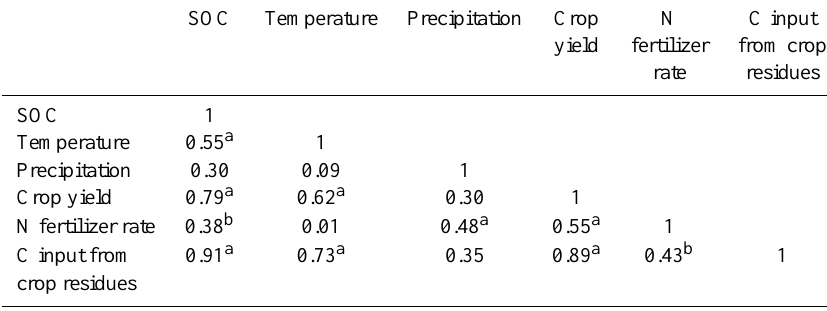
Table 1. Correlation analysis between SOC content of cropland and driving factors in Huantai County. SOC Temperature Precipitation Crop N C input yield fertilizer from crop rate residues SOC